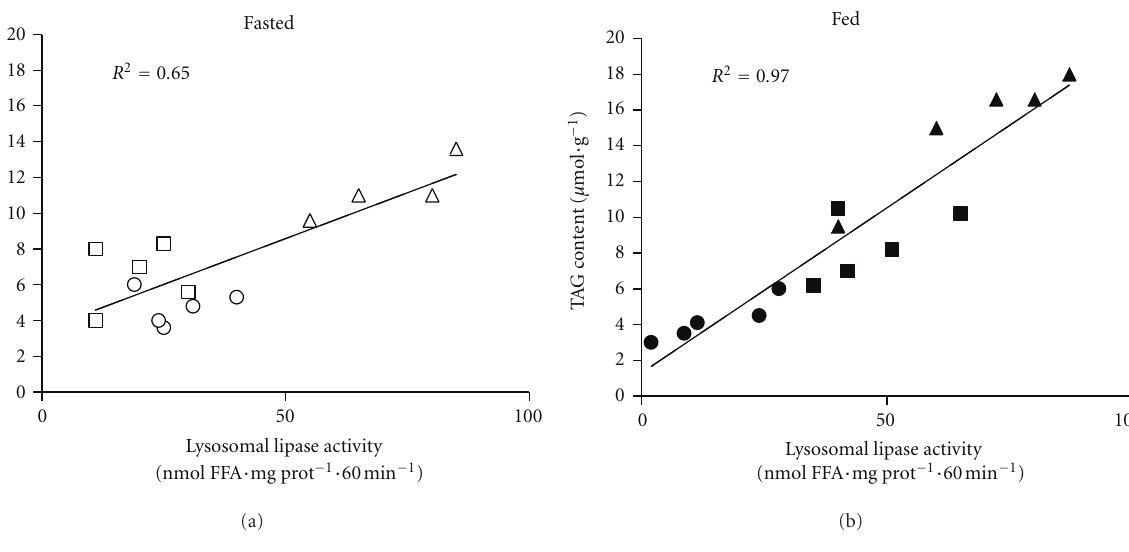
Figure 4: The correlation between lysosomal lipase activity and hepatic triacylglycerol content in fasted (a) and fed (b) animals. Lysosomal lipase activity was determined as the FFA release from endogenous TAG. Open circle = SD-fasted; open square = HS-fasted; open triangle = HF-fasted; closed circle = SD-fed; closed square = HS-fed; closed triangle = HF-fed.